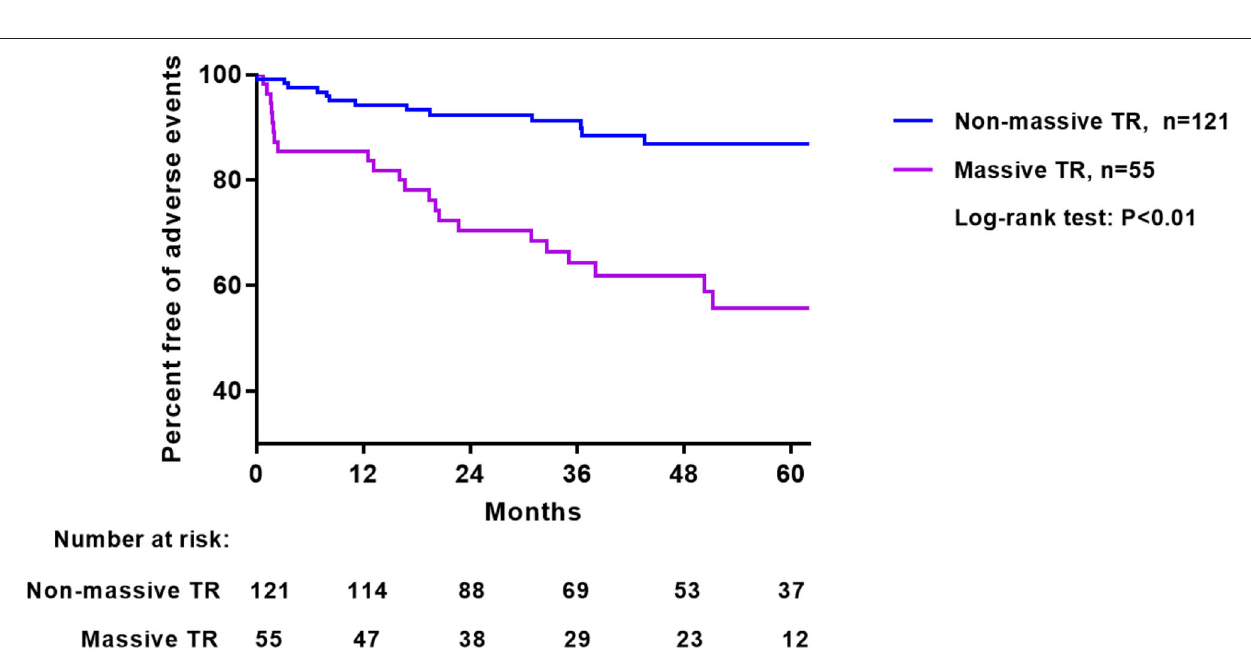
FIGURE 1 | Change in model Chi square with addition of massive tricuspid regurgitation (TR) to the other risk factors. The including parameters of each primary model was same as Table 3 .